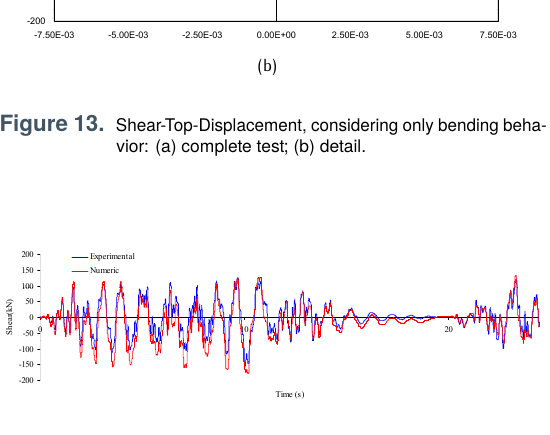
Figure 14. Column shear evolution in time considering bending and shear